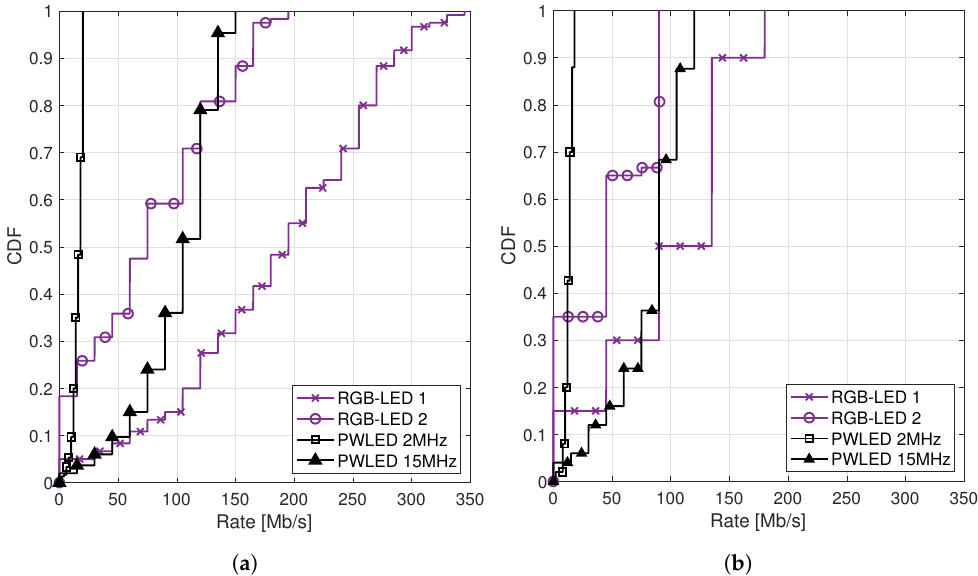
Figure 7. CDF of the users’ rates obtained in a system with K = 6 users for the ( a ) optimal precoder and ( b ) pseudoinverse precoder. The CDFs have been obtained with 1000 independent realizations varying randomly the users’ positions. For each realization, the BER requirement is satisfied through the variation of the M-PAM constellation. “RGB-LED” refers to a system with N = 12 RGB units, each unit composed of one red, one green, and one blue LED placed together. “PWLED” refers to a system with 12 phosphor-coated LEDs.